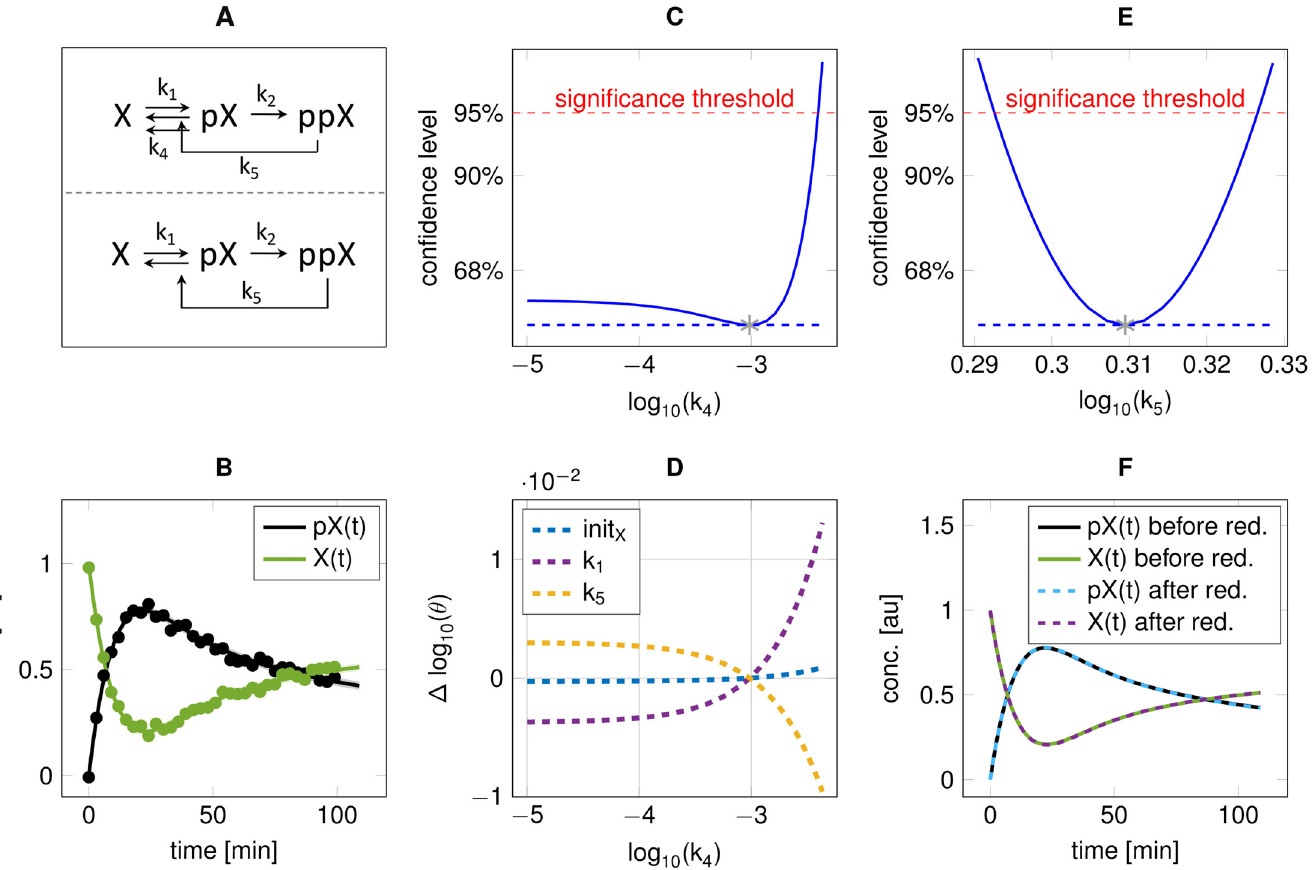
Fig 3. Reduction of the cascade toy model 2 (scenario 2). A: Model scheme before (upper) and after (lower) reduction. The difference is the basal deactivation from pX to X with rate constant k 4 . B: X ( t ) and pX ( t ) with data for fitted parameters. C: Profile likelihood for parameter k 4 . D: Relationship of the remaining parameters to the profile shown in C. E: The reaction associated with the parameter k 4 is removed by the reduction, while k 5 is identifiable. F: pX ( t ) and X ( t ) with comparison before and after reduction.